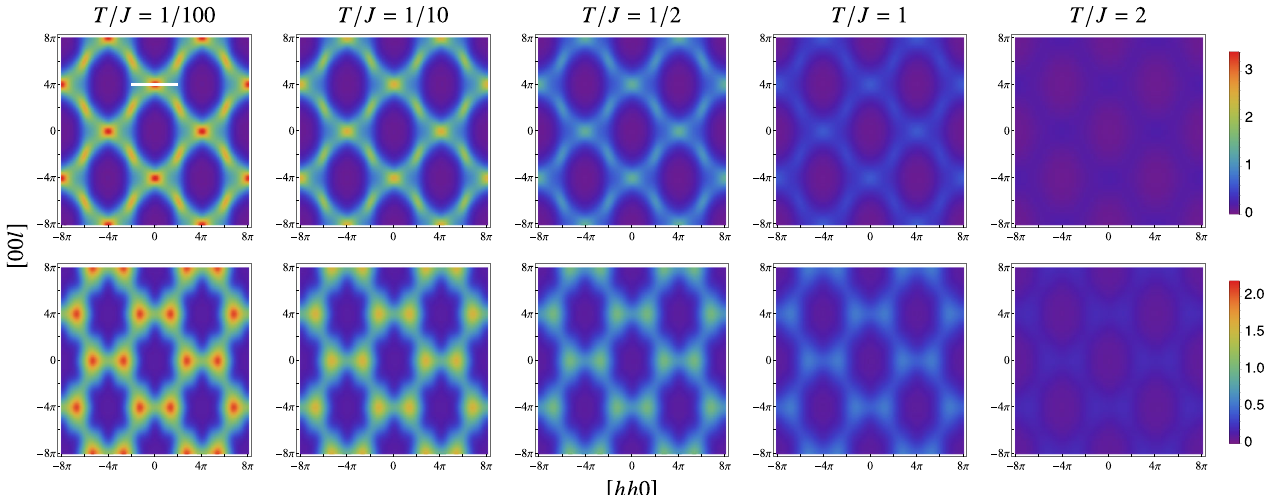
FIG. 18. The spin susceptibility profile (in units of 1 =J ) in the ½ hhl (cid:2) plane shown at different temperatures for the S ¼ 1 = 2 J 1 - J 2 Heisenberg model. The first row is for antiferromagnetic J 2 (evaluated at J 2 =J 1 ¼ 0 . 1 ) and the second row for ferromagnetic J 2 (evaluated at J 2 =J 1 ¼ − 0 . 1 ).